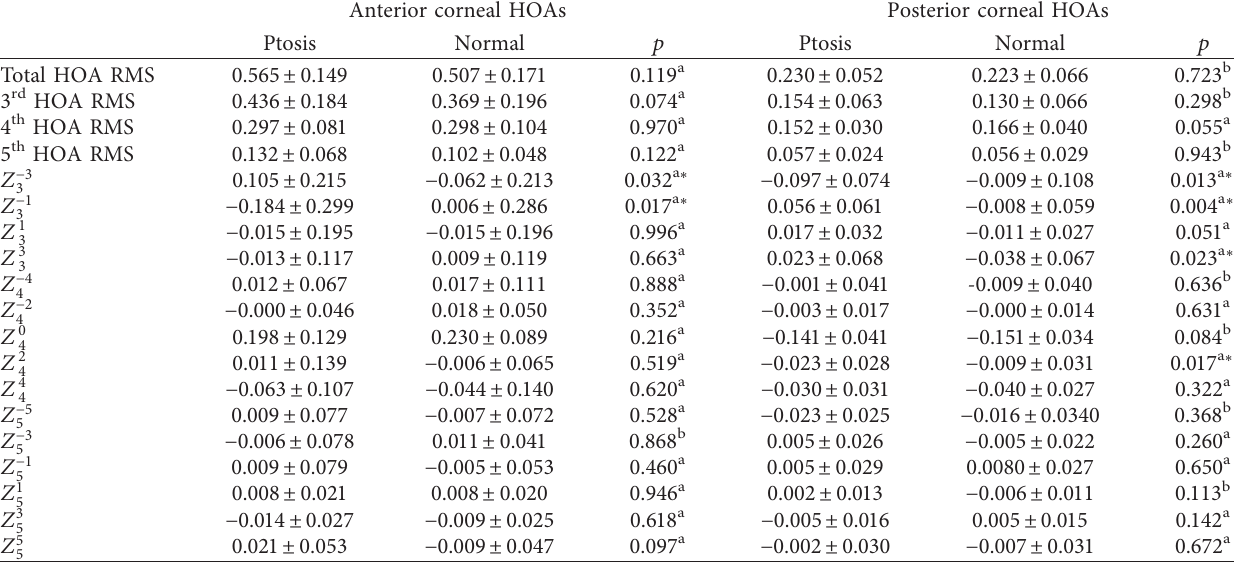
Table 2: Comparison of corneal higher-order aberrations (HOAs) between the ptosis group and the normal group. Anterior corneal HOAs